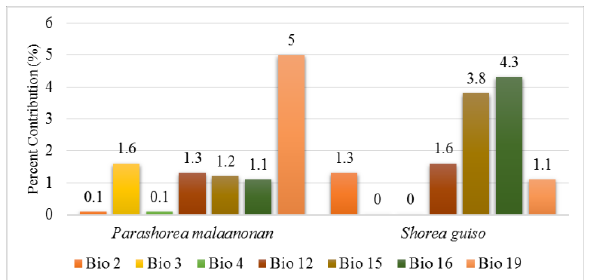
Figure 2. Percent contribution of bioclimatic variables derived from Maxent models and its influence on the geographic distribution of P. malaanonan and S. guiso .